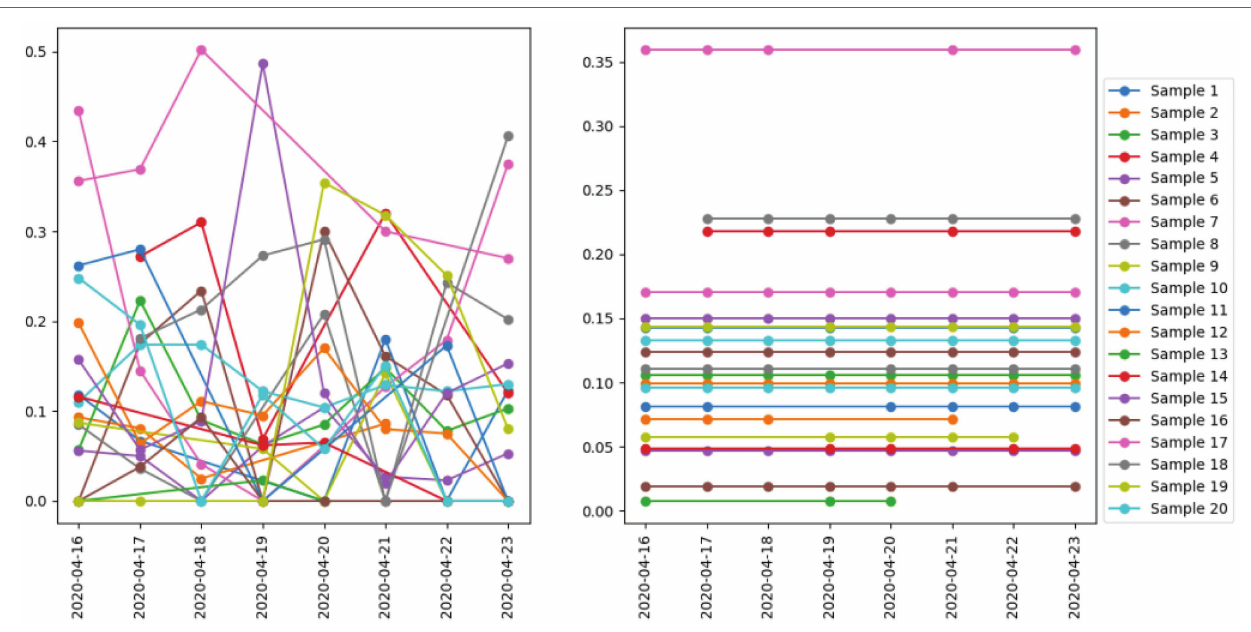
FIGURE 2 | Positive affect fluctuates on a daily basis, highlighting the necessity of intensive measurement. Note. On the left, it shows the daily estimated positive affect for 20 randomly sampled users. On the right, it shows the averaged results for the same 20